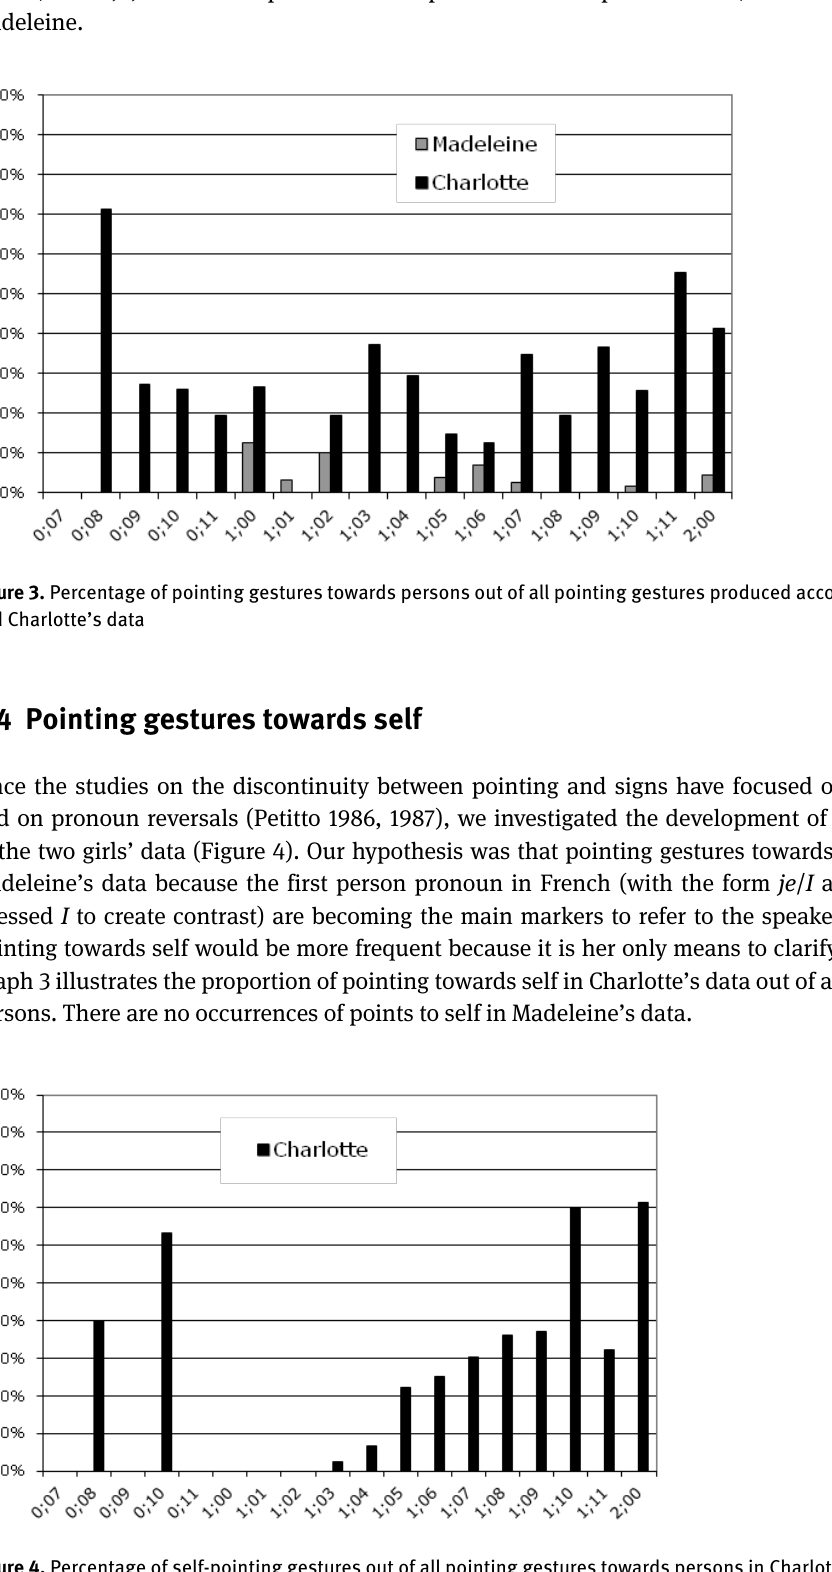
Figure 4. Percentage of self-pointing gestures out of all pointing gestures towards persons in Charlotte’s